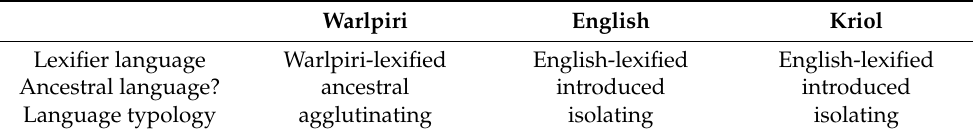
Table 2. How the three source languages of Light Warlpiri are categorized into two groups. Warlpiri English Kriol Lexifier language Warlpiri-lexified English-lexified English-lexified ancestral introduced introduced Language typology agglutinating isolating